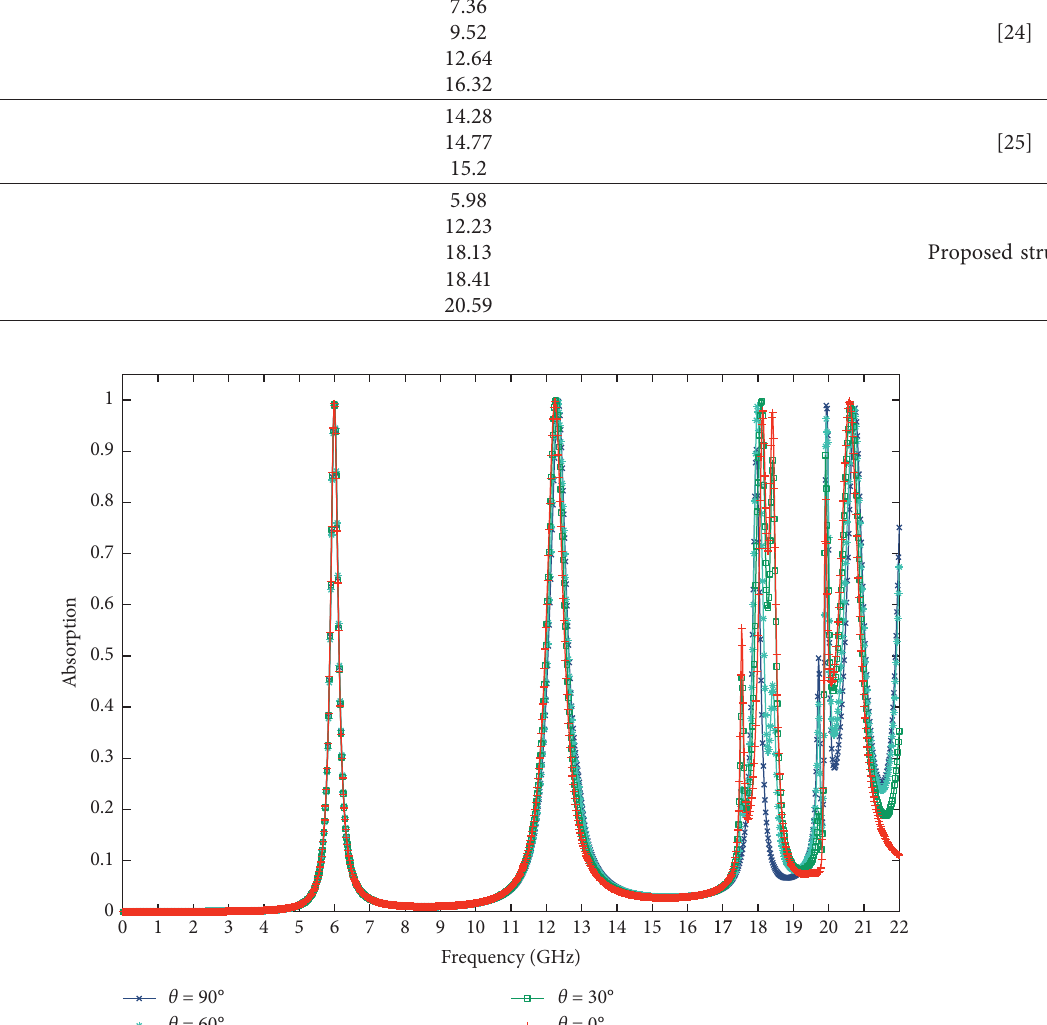
Figure 3: Effect of polarization angle on absorption spectrum during electromagnetic wave